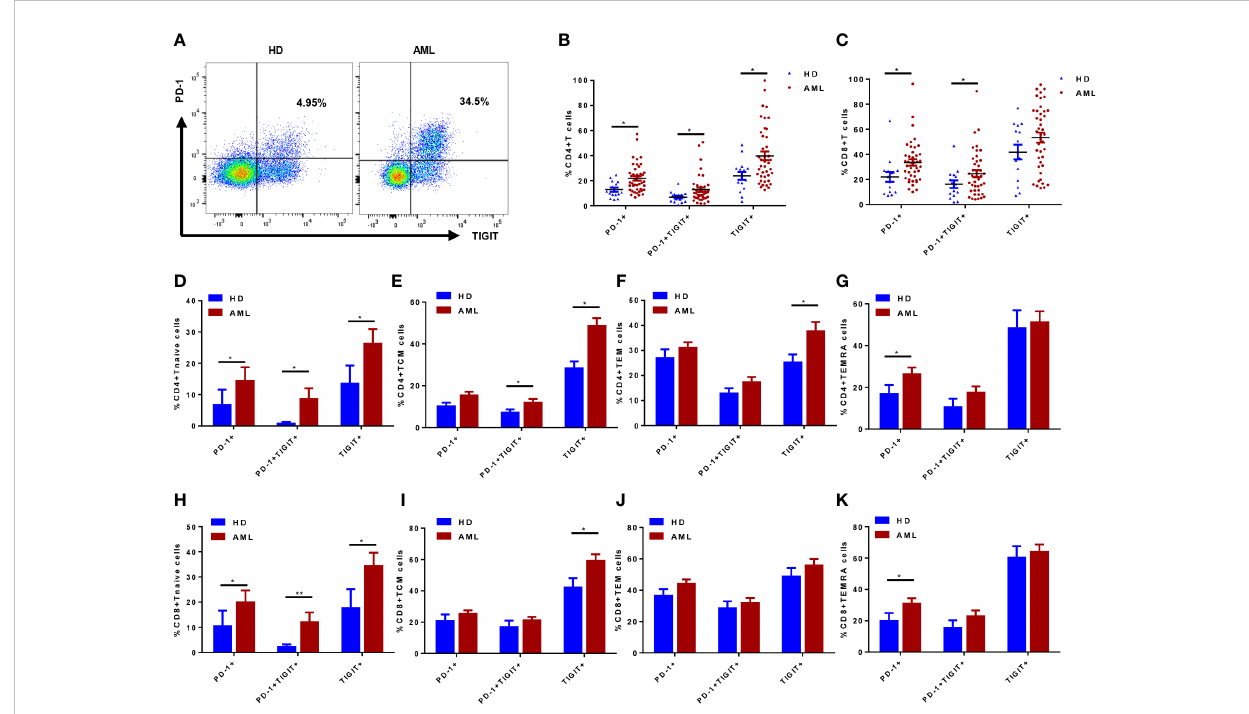
FIGURE 2 Inhibitory receptors PD-1 and TIGIT expression in T cells and their differentiated subsets from bone marrow (BM) of de novo AML patients (n=42) and healthy donors (HDs, n=15). PD-1 and TIGIT expression was determined in de novo AML patients and HDs (A) ; The percentages of PD-1 + , TIGIT + and PD-1 + TIGIT + subsets of CD4 + (B) and CD8 + (C) T cells in BM of de novo AML patients and HDs were compared. Moreover, PD-1, TIGIT and coexpression of PD-1 and TIGIT were evaluated in Tnaive, TCM, TEM and TEMRA subsets of CD4 + (D – G) and CD8 + (H – K) T cells in BM of de novo AML patients and HDs. Student ’ s t test or Mann-Whitney U test was used to analyze the data according to normal distribution of data. *, ** indicated p-values between 0.01 to 0.05, 0.001 to 0.01